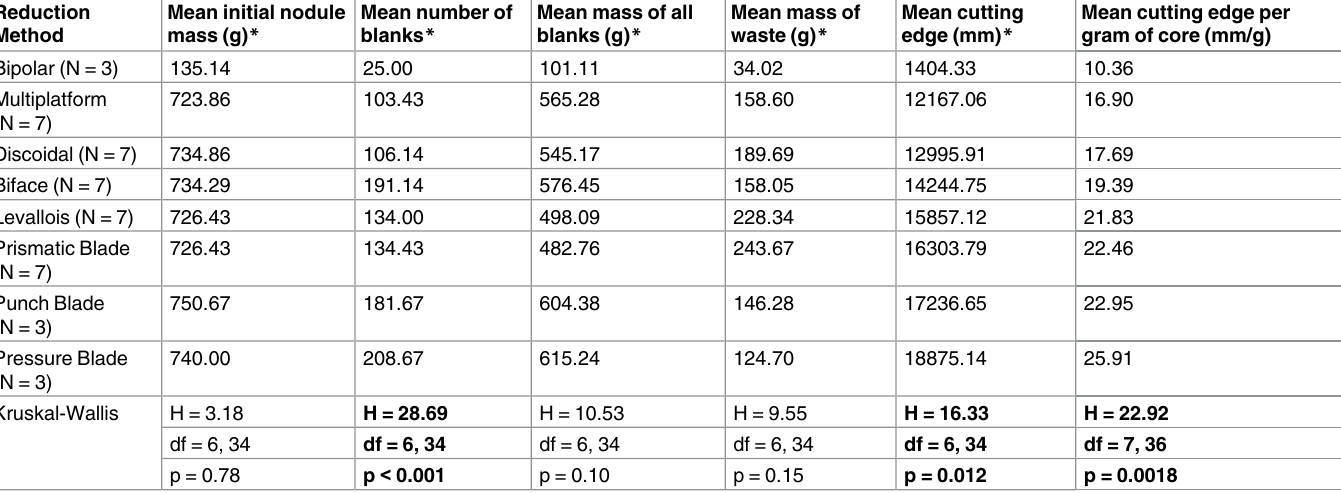
Table 2. Mean mass, counts and cutting edge values for each reduction strategy. Kruskal-Wallis tests were conductedfor each variablebased on the values of the three or seven repetitionsof each reductionmethod. Variablescontaining significantdifferences amongthe eight different technologies at the α = 0.05 level are represented in bold. * The bipolarvalues were not includedin the first five statistical comparisons, as significantly smaller cores were used owingto the typically small size of bipolar